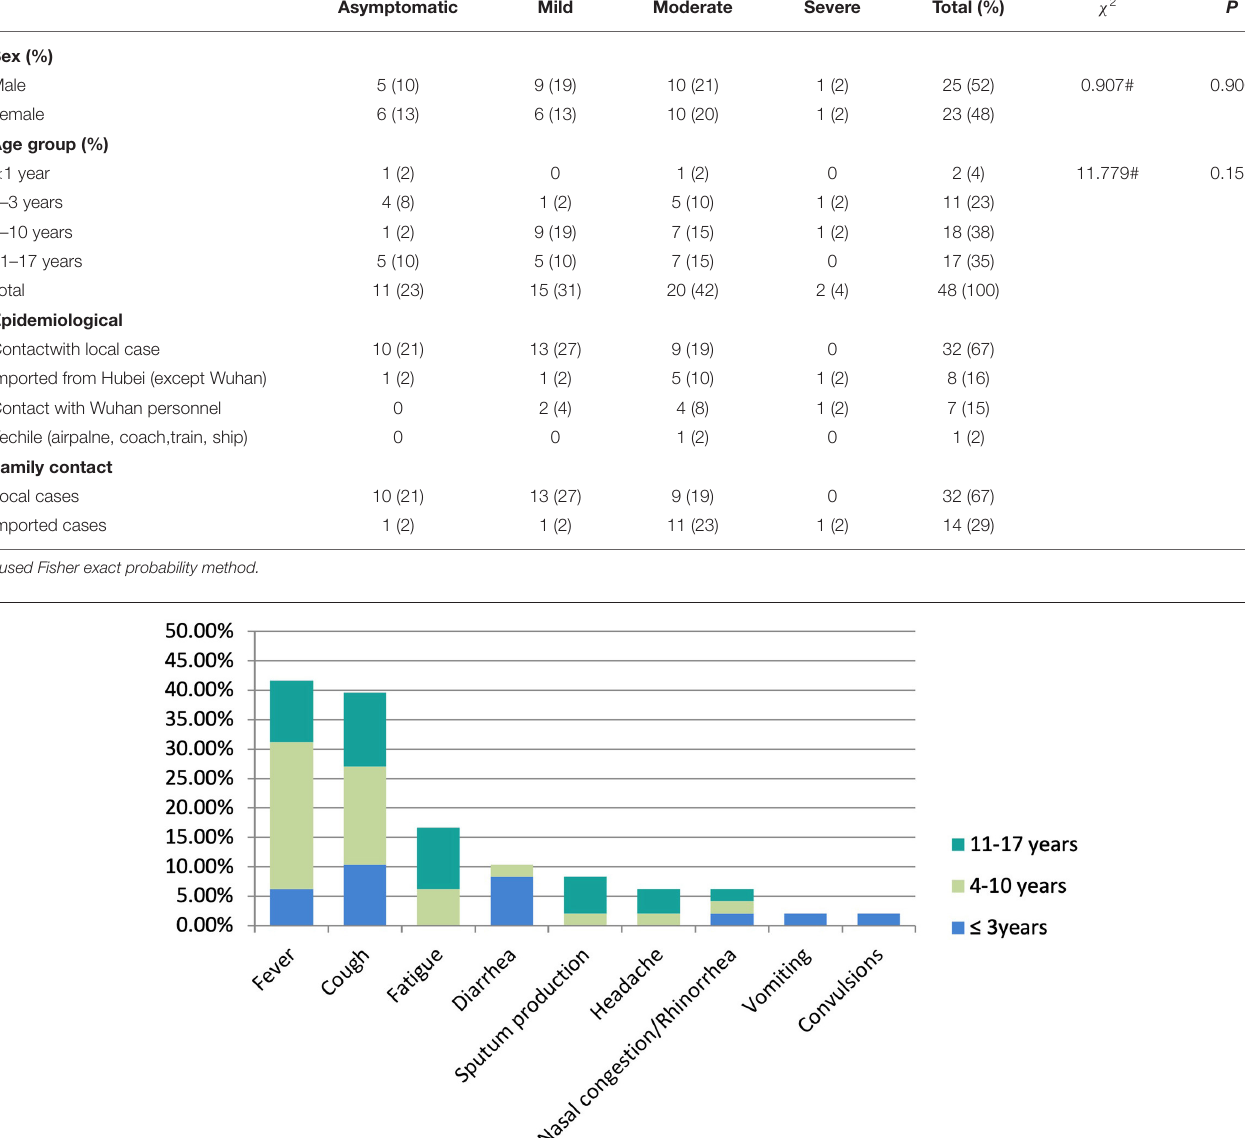
TABLE 1 | Demographic characteristics and disease severity distribution of 48 children infected with COVID-19. Asymptomatic Mild Moderate